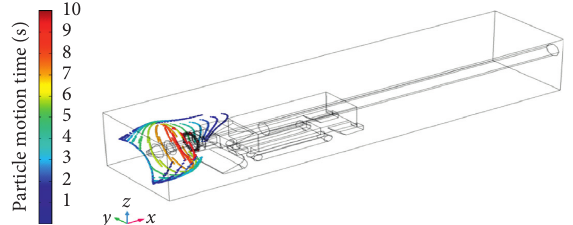
Figure 14: Particle trajectory with an air volume of 3m 3 /min.